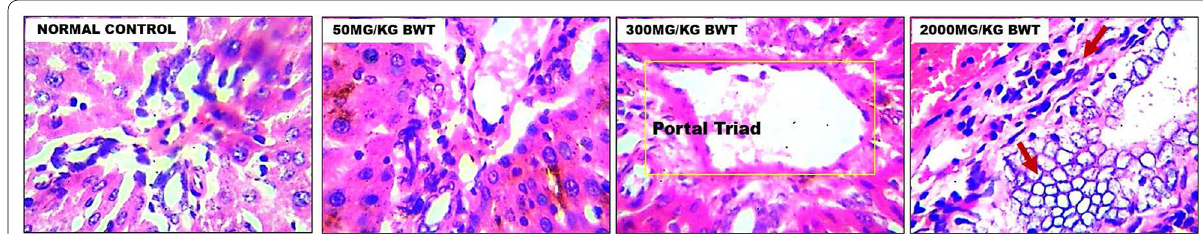
Fig. 7 Liver micromorphological section demonstrated by Haematoxylin and Eosin staining at high magnification (X400). The hepatocytes, sinusoids, portal triad (hepatic vein, hepatic artery and bile duct) are all visible across the various groups. Red arrow indicates severe altered morphology characterized with fibrosis, heamorhage, parenchymal loss and cellular loss